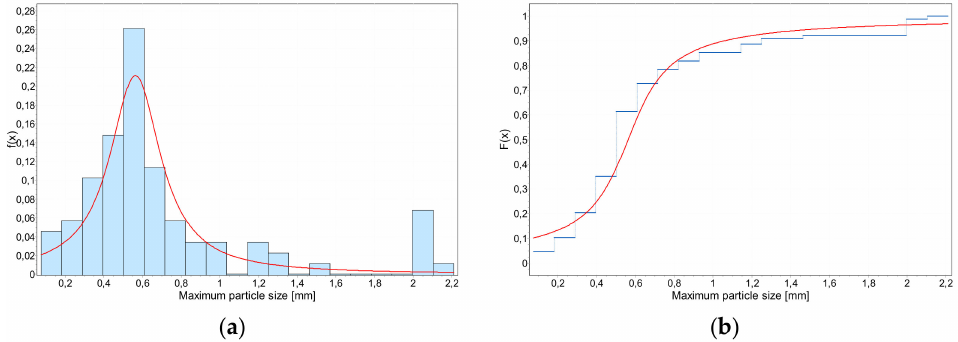
Figure 6. ( a ) Probability density function and ( b ) cumulative distribution function of the rubber particle